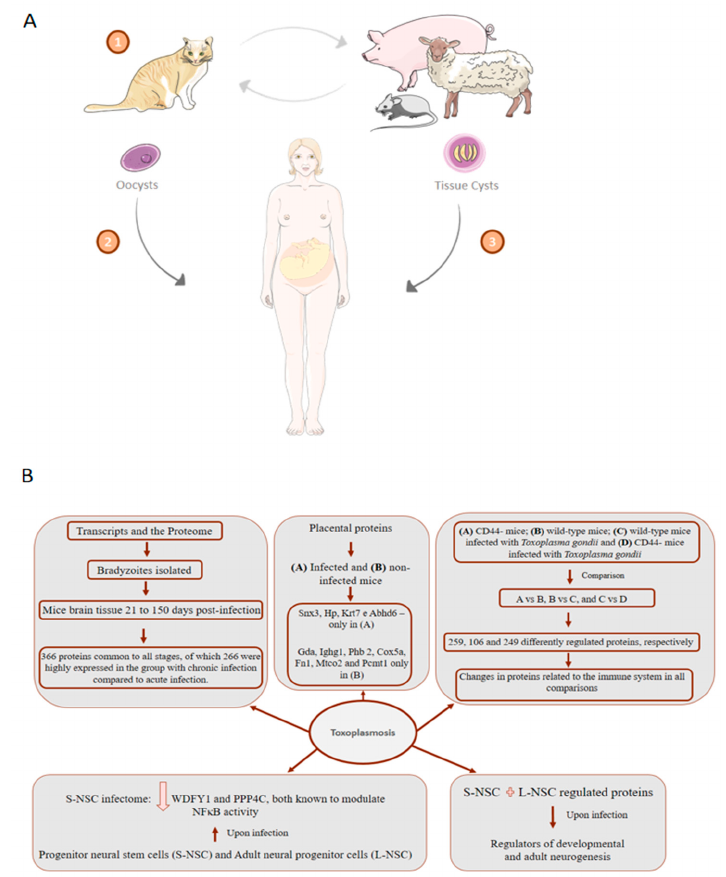
Figure 6. Toxoplasmosis transmission cycle and representative proteomics-driven studies. ( A ) (1) In the cat, after ingesting tissues containing oocysts or cysts, these are released into the body and penetrate the intestinal epithelium where they undergo asexual reproduction followed by sexual reproduction, transforming into oocysts and can be excreted together with the feces. Oocysts can survive for months in the environment and are resistant to disinfectants, freezing, and drying, but destroyed by heating at 70 ◦ C for 10 min. Other animals, such as pigs, sheep, rats, and including man (2) (intermediate hosts), can consume oocysts present in the environment and become contaminated. The oocyst ruptures in the intestine of the intermediate host, releasing the sporozoites that invade the enterocytes. In the enterocyte, each parasite is called a tachyzoite. Tachyzoites spread through the animal’s body and can form cysts in nervous and muscular tissue, which can be consumed by humans and cause infection (3). Tachyzoite multiplies asexually and disrupts the host cell. After the invasion of a new cell by a tachyzoite, the asexual cycle can lead to the formation of intracellular bradyzoites. The formation of bradyzoites begins to occur with greater intensity when the intermediate host develops specific immunity. ( B ) Main findings indicated by proteomic studies that explore the proteome of toxoplasmosis